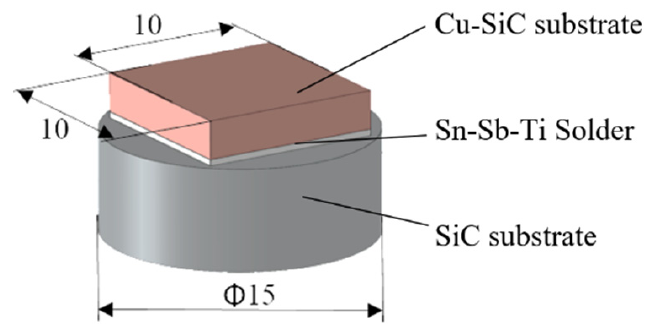
Figure 5. Schematic representation of the specimen for the shear strength test of the Cu–SiC/Sb–Sb–Ti/SiC joint.